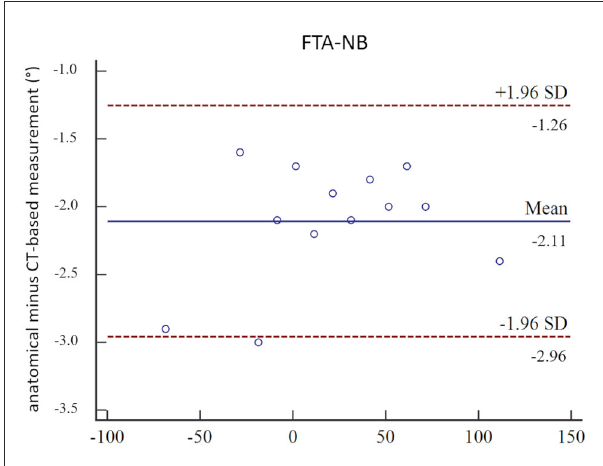
FIGURE3 Bland–Altman plots. Bland–Altman plots of the comparison between manual anatomical (goniometer) and CT-based (software) femoral neck version angle measurements (FTA-NB) in a canine femoral diaphyseal torsional deformity model in 13 preset femoral torsion angles.